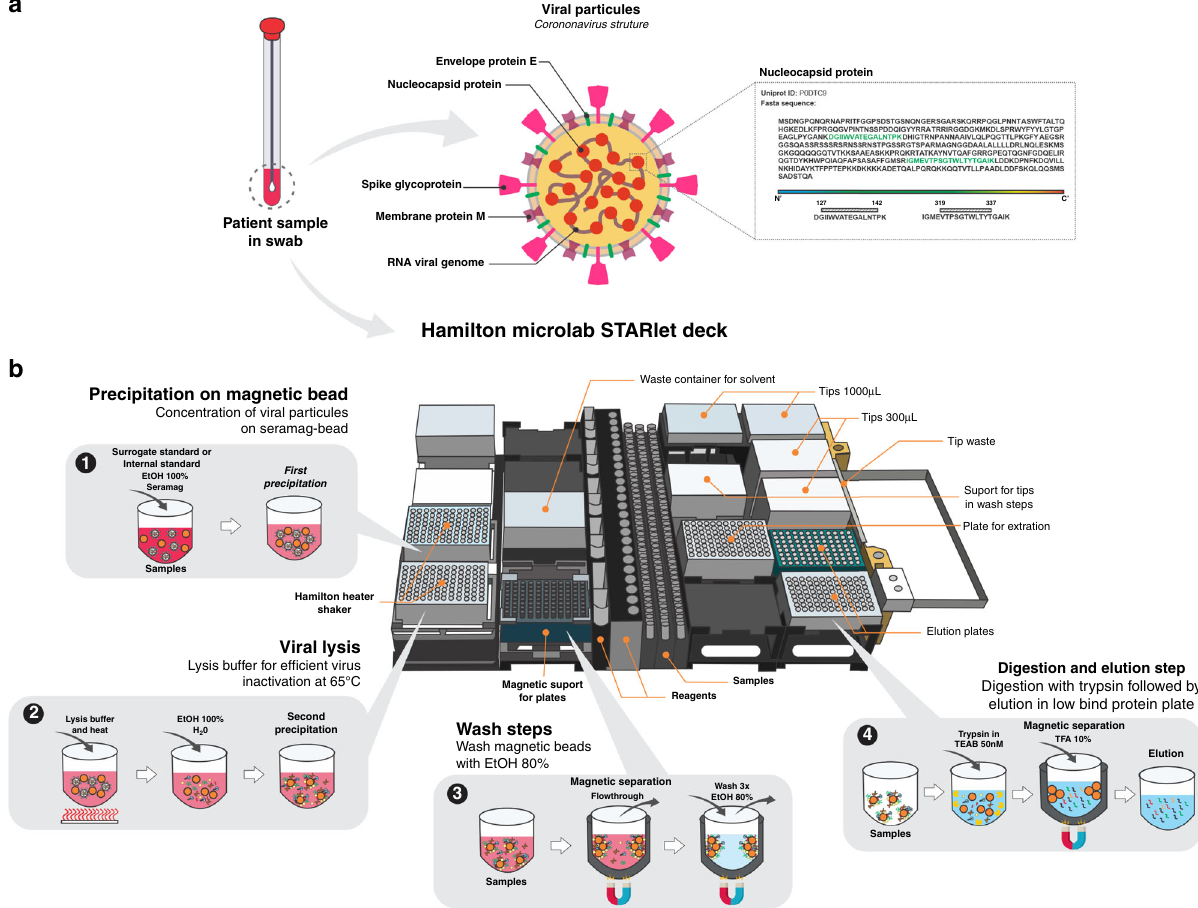
Fig. 4 Overview of automated sample preparation for SARS-CoV-2 SP3-based extraction on a Hamilton Robotics Microlab STARlet liquid handling system. a Patient samples were collected with swabs placed in virus transport medium or sterile saline solution and stored at − 80 °C before automated sample processing. The highlighted nucleocapsid peptides were monitored by turbulent fl ow chromatography coupled to tandem mass spectrometry. b Schematic overview showing the steps and Hamilton desk setup for automated SP3 sample processing: (1) viral particle and internal standard precipitation on magnetic bead using ethanol (EtOH) to a fi nal concentration of 50% (v/v); (2) one-step viral lysis using a sodium dodecyl sulfate-based (SDS) buffer and dithiothreitol (DTT) for 5 min at 65 °C followed by dilution and bead precipitation; (3) magnetic separation and three consecutive wash steps with ethanol 80% (v/v); (4) protein elution from magnetic bead followed by digestion with trypsin in triethylamonium bicarbonate buffer (TEAB) for 2 h at 37 °C, post-digestion acidi fi cation with tri fl uoroacetic acid (TFA), and recovery of peptides in a new sample